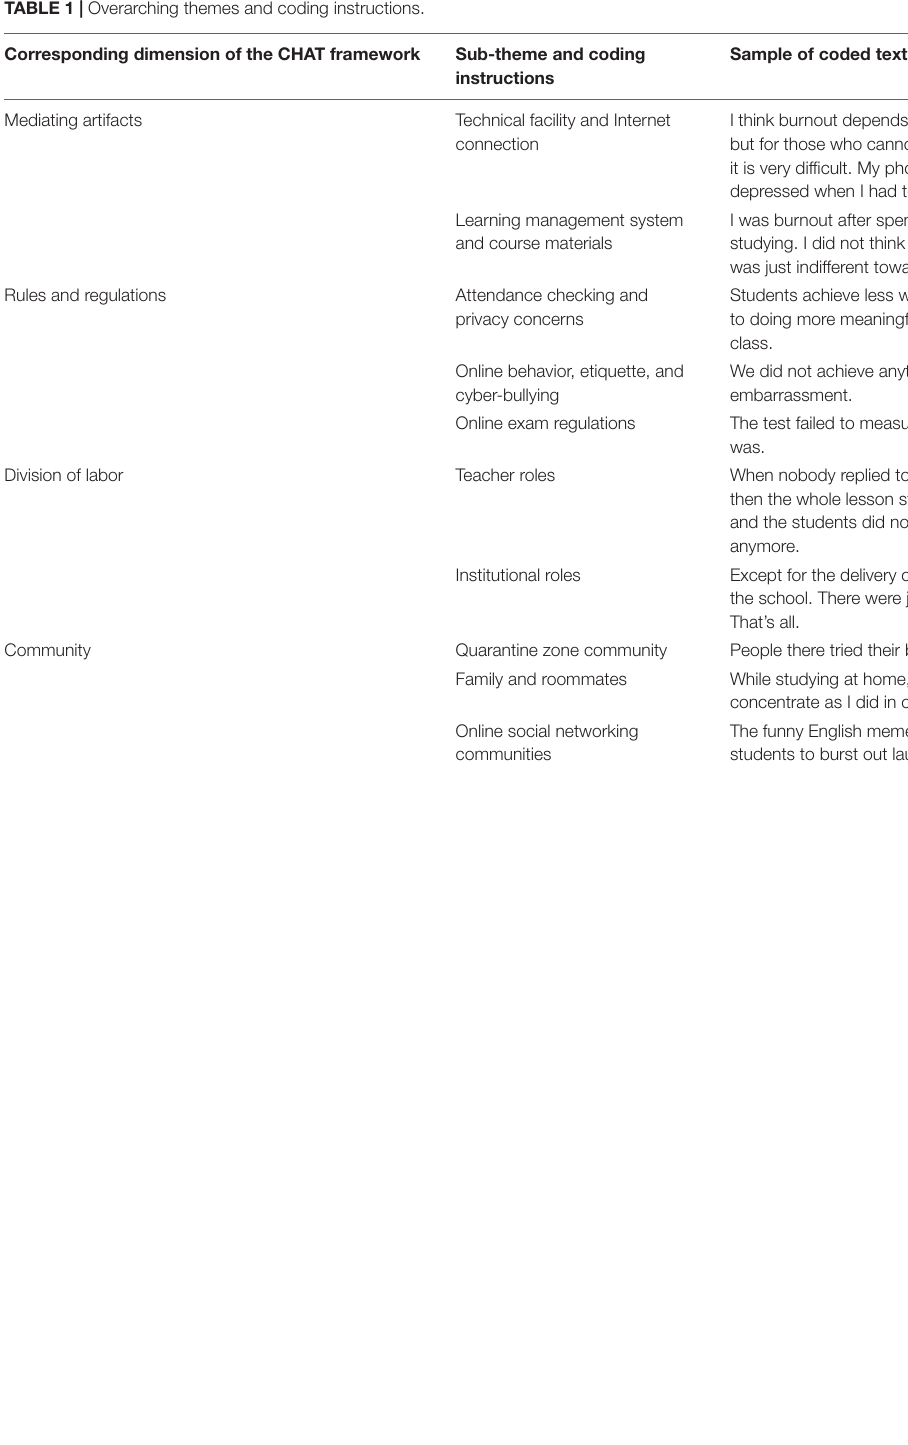
TABLE 1 | Overarching themes and coding